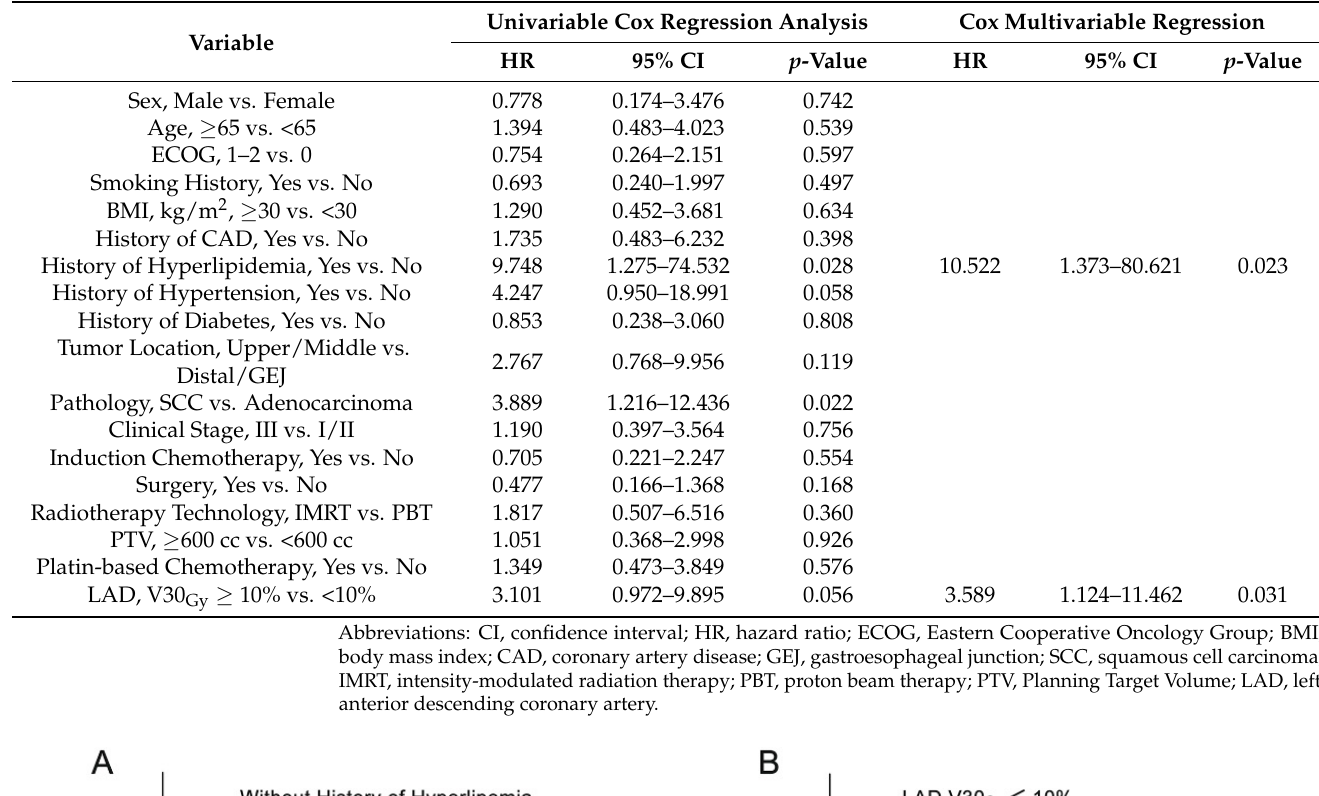
Table 2. Univariable and multivariable analysis for time to earliest major coronary events.